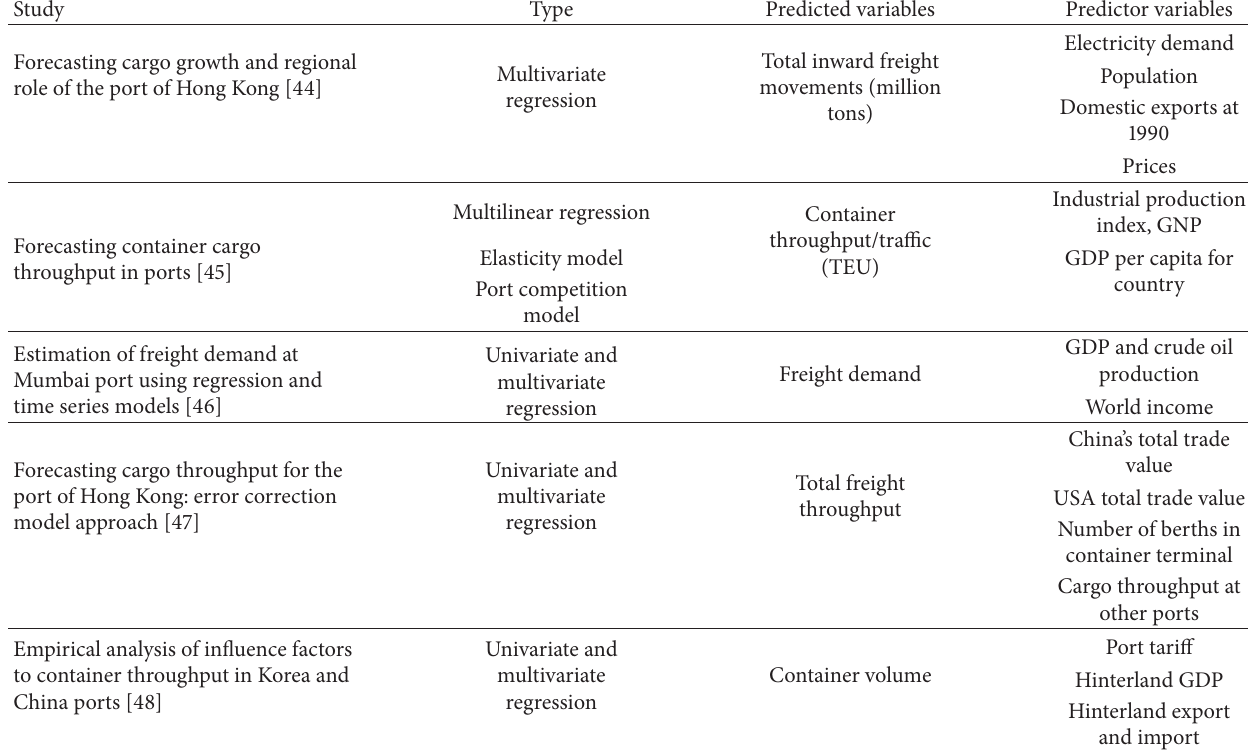
Table 1: Summary of previous studies on seaports’ freight demand